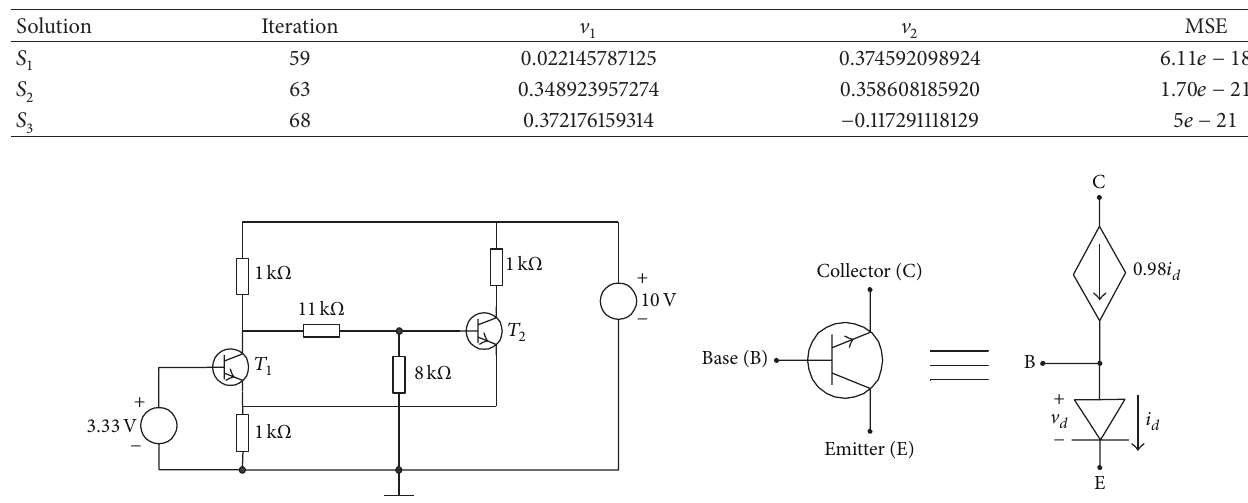
Table 3: Numerical solutions for (17).